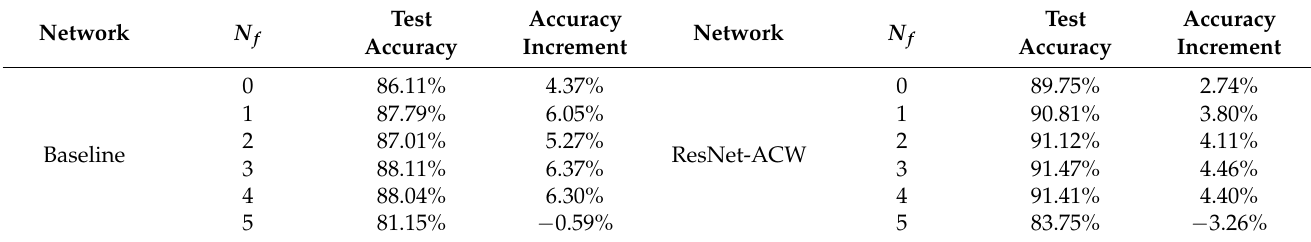
Table 11. Test results of fine-tuning by changing the number of frozen